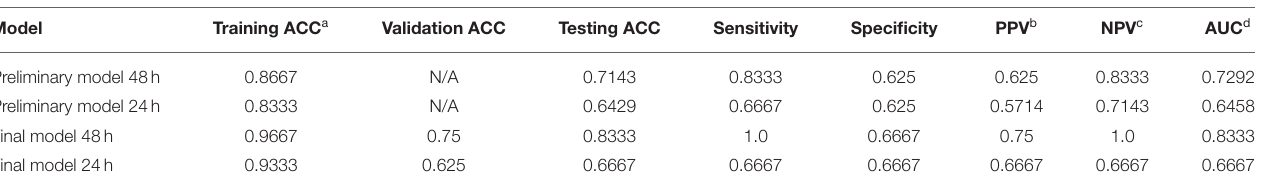
TABLE 3 | Model performance with different input data